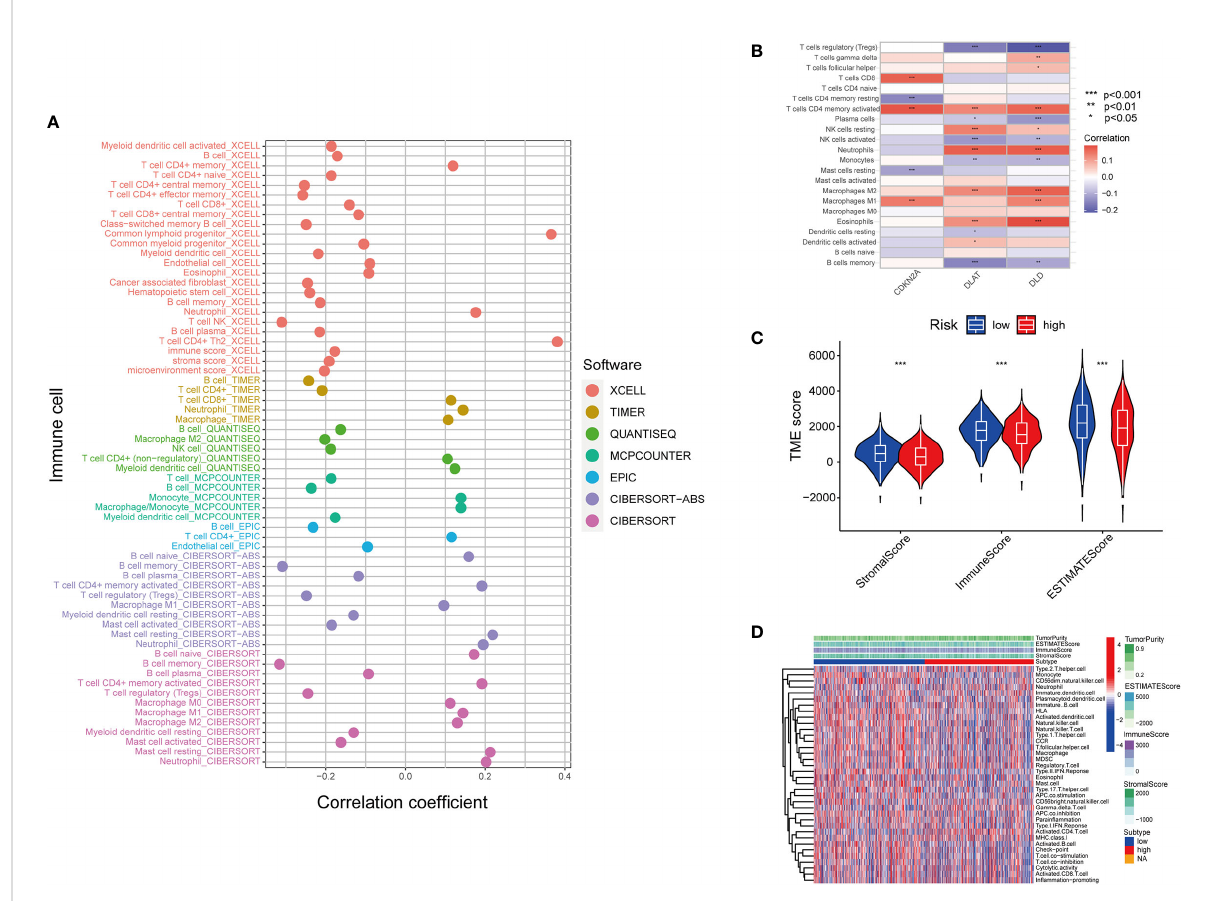
FIGURE 5 Inferring the TME of LUAD samples with different cuproptosis statuses. (A) Correlation between cuproptosis gene model and immune cell in fi ltration inferred by different bioinformatic tools. (XCELL, TIMER, QUANTISEQ, MCPCOUNTER, EPIC, CIBERSORT-ABS, and CIBERSORT.) (B) Correlation between the immune cell in fi ltration and the differentially expressed cuproptosis-related gene model. (For example, one of the cuproptosis biomarker CDKN2A has a positive correlation with CD8+T cell in fi ltration, CD4+T cell memory and M1 subtype macrophages.) (C) Correlation between cuproptosis-based risk assessment and TME components. (D) Estimation of TME components and enriched pathways in the high and low-risk groups determined by cuproptosis-related gene model (*, p<0.05; **, p<0.01' ***,